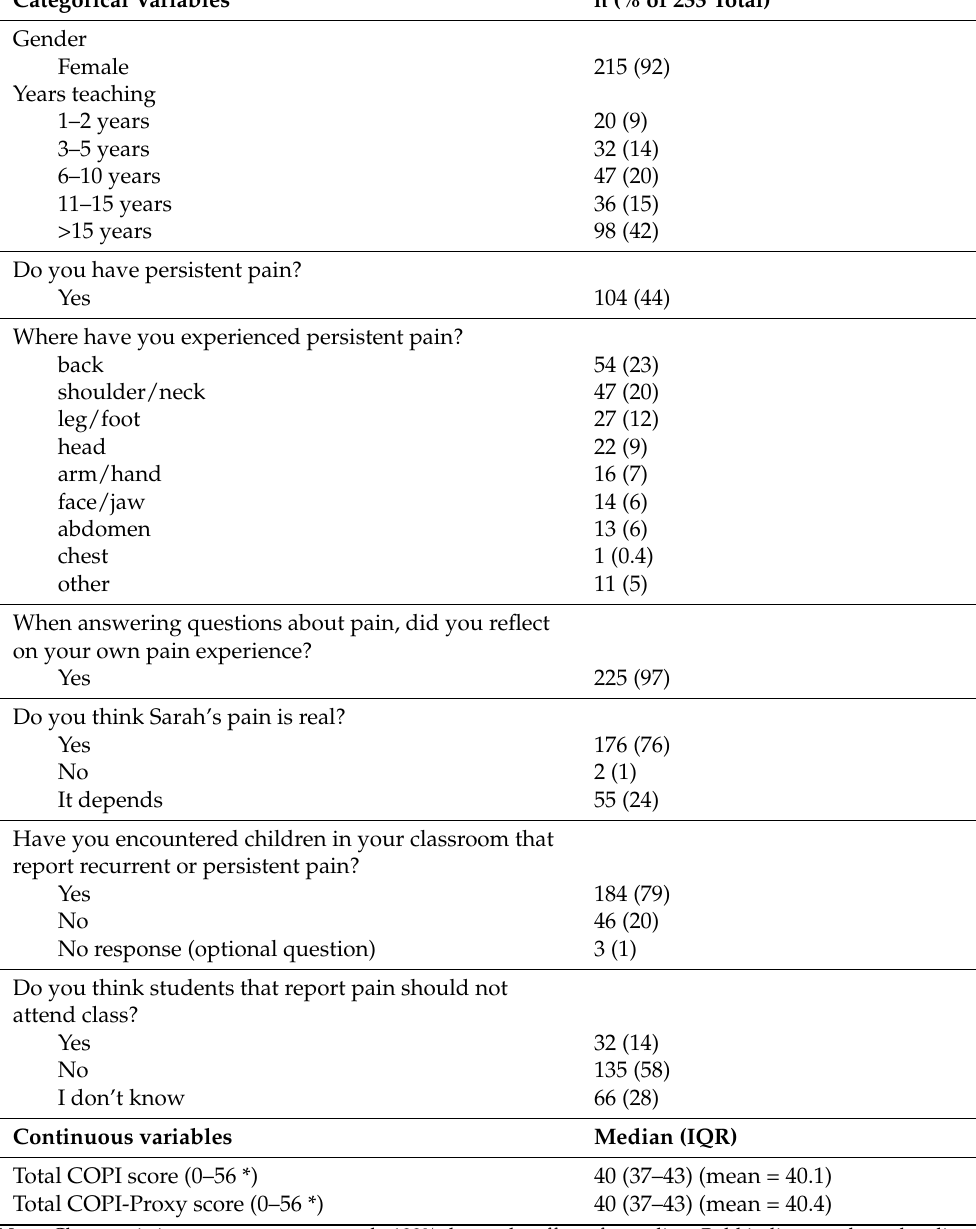
Table 1. Demographic and clinical variables of